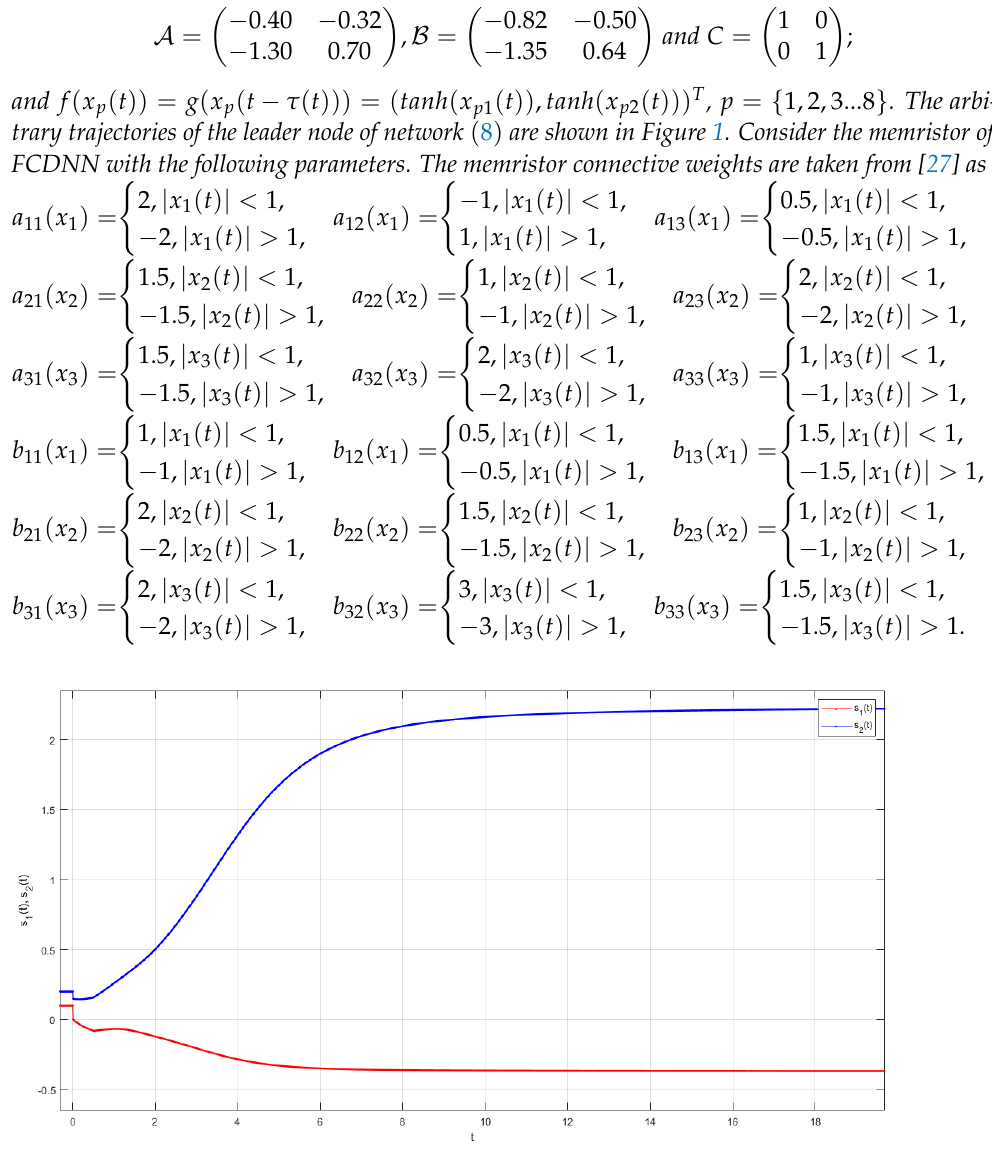
Figure 1. Orbit trajectory of leader